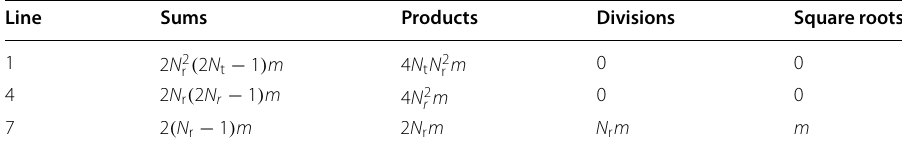
Table 1 Computational operations power iteration algorithm Line Sums Products Divisions Square